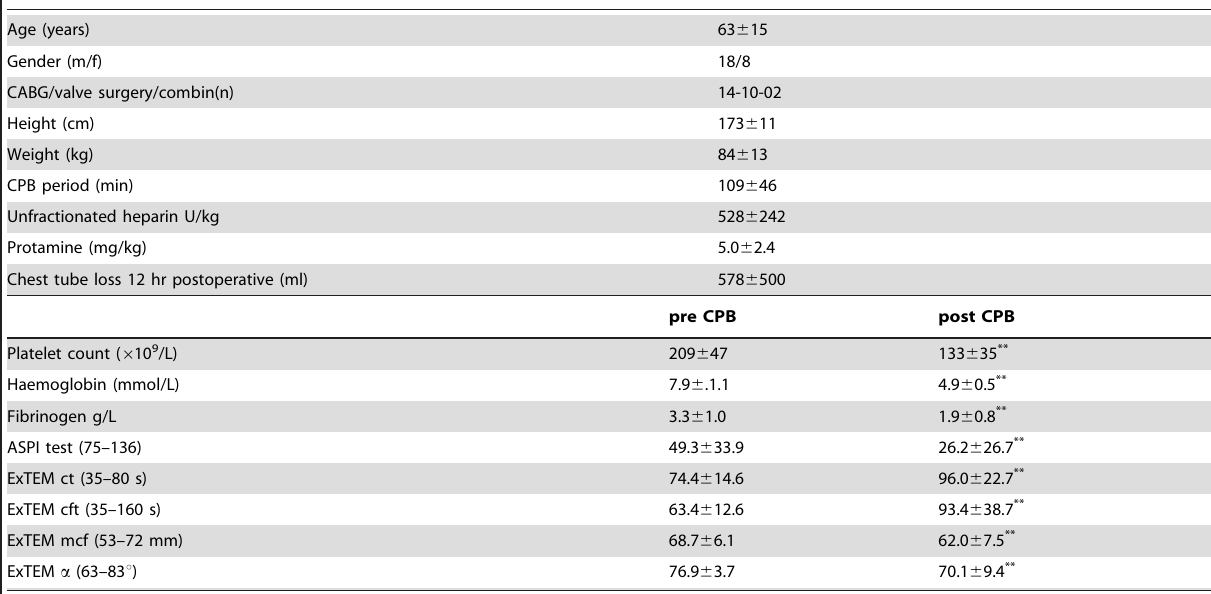
Table 1. Demographic data of the 26 patients